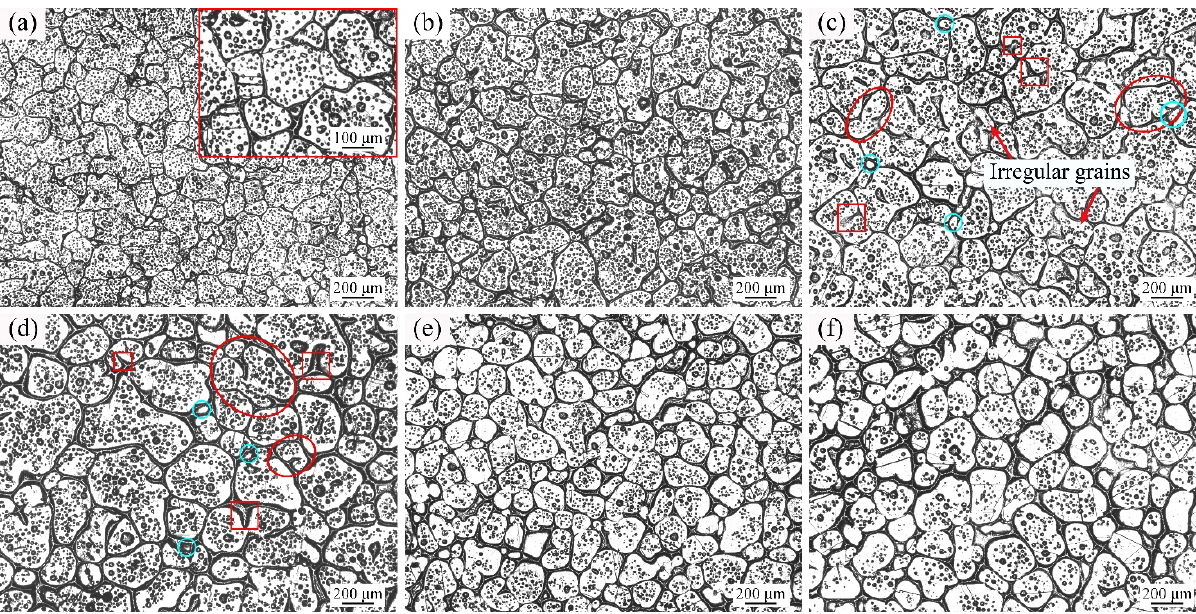
Figure 5. Optical micrographs of GH3536 alloy heat treated at 1364 °C for ( a ) 5 min, ( b ) 15 min, ( c ) 30 min, ( d ) 60 min, ( e ) 90 min, and ( f ) 120 min.